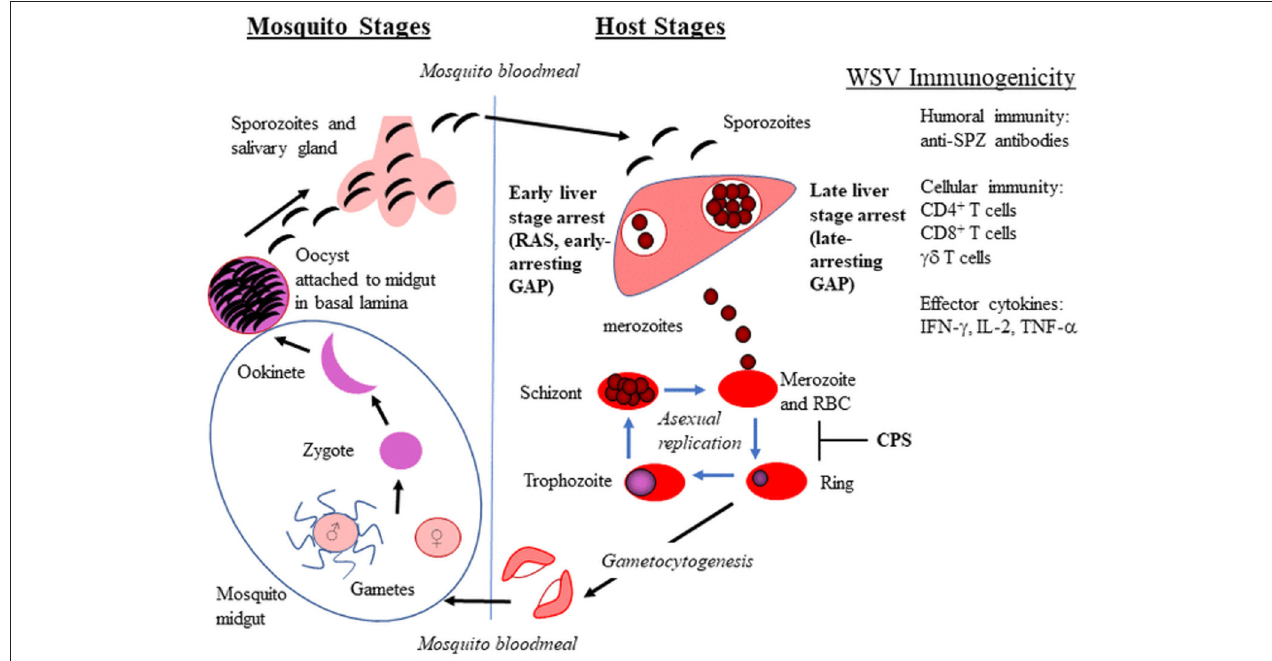
FIGURE 1 | Plasmodium life cycle in mosquitoes and vertebrate hosts. The whole sporozite vaccine (WSV) strategy for radiation attenuated sporozoites (RAS), genetically attenuated parasites (GAP), and chemoprophylaxis with WT sporozoites (CPS) is shown in bold. The WSV immunogenicity provided by WSV administration is also